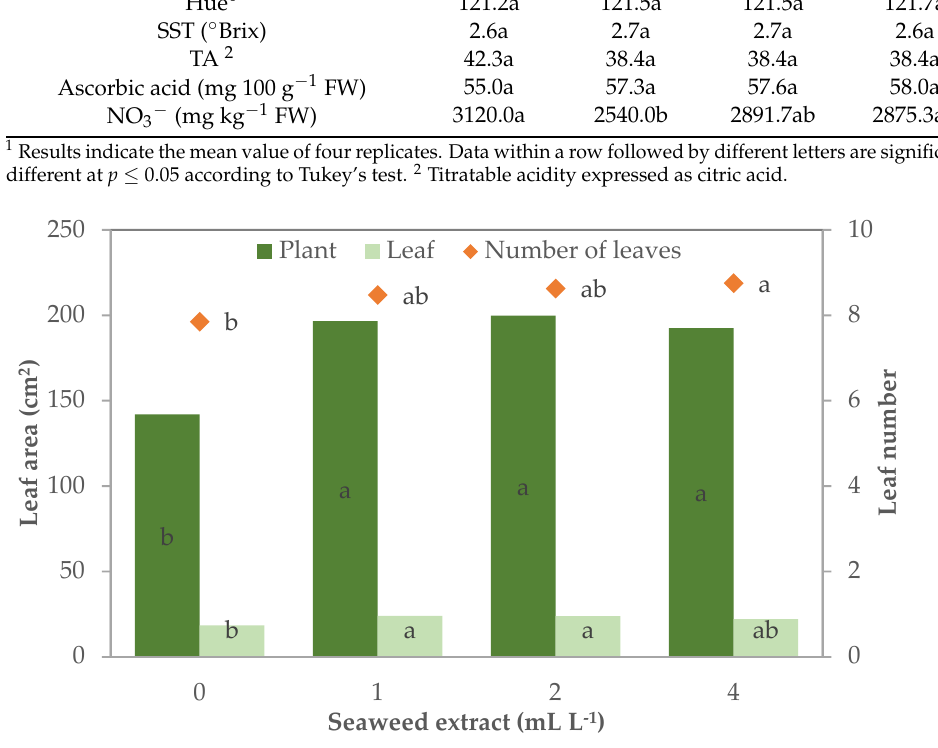
Figure 4. Leaf number and plant and leaf area of leaf lettuce plants grown in nutrient solutions with different concentrations of a seaweed extract from Ecklonia maxima (bars of the same color or points with different letters are significantly different at p ≤ 0.05 according to Tukey’s test).